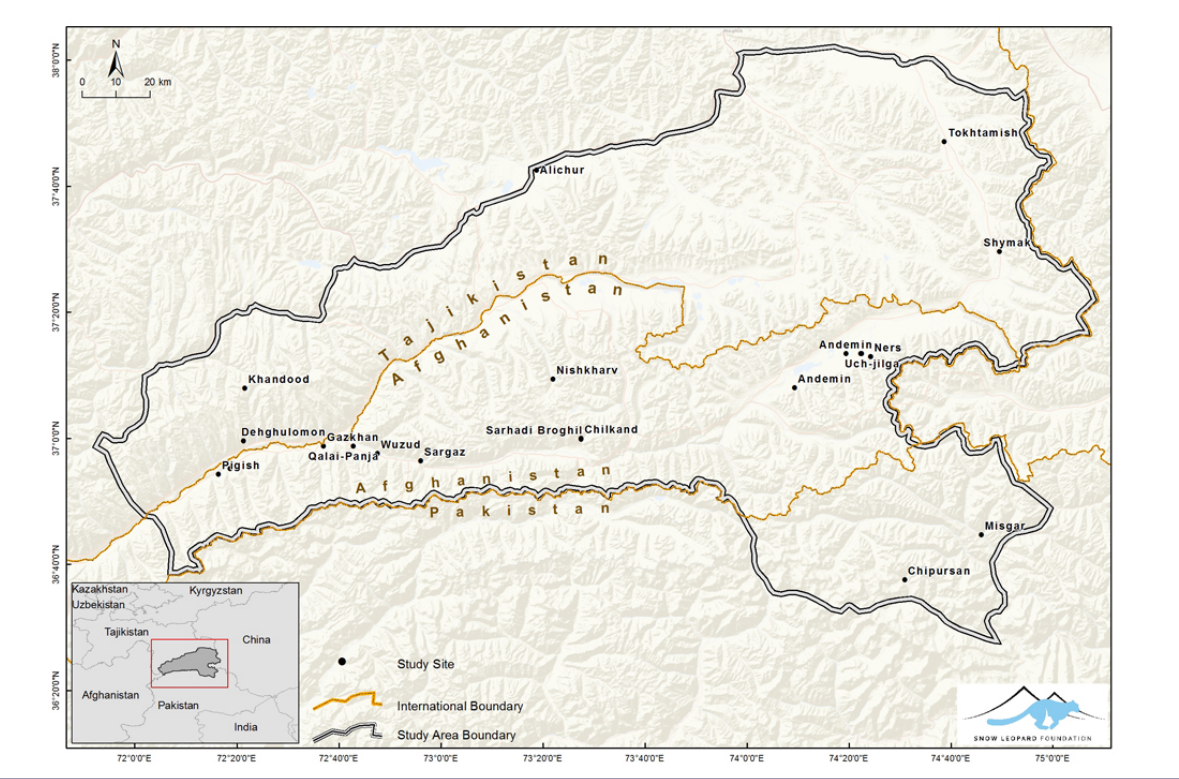
Fig. 1 . Map of the Pamirs showing data collection